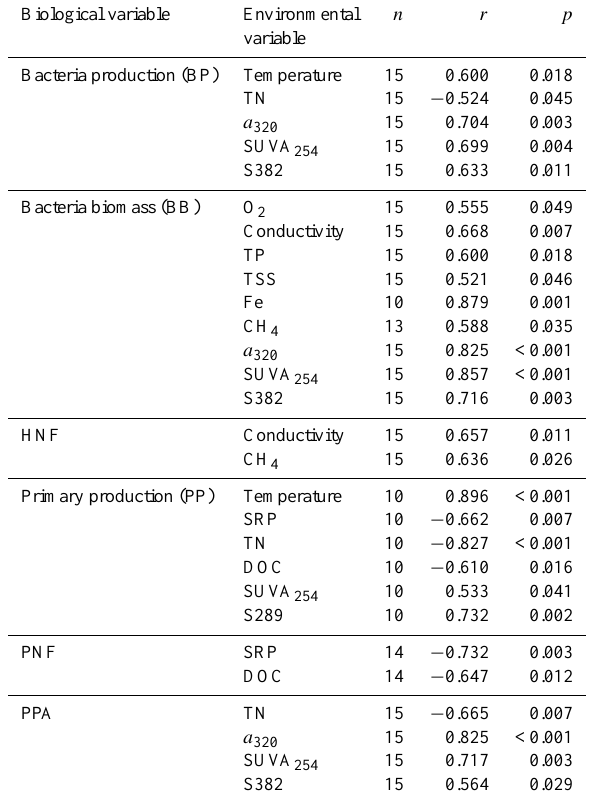
Table 4. Spearman correlations between biological and envi- ronmental variables. Only statistically significant correlations are